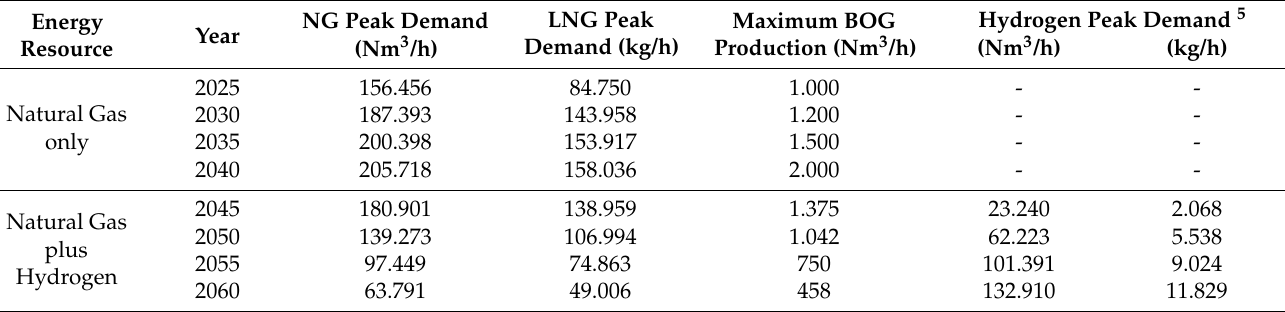
Table 7. Peak demand estimation for natural gas and hydrogen.